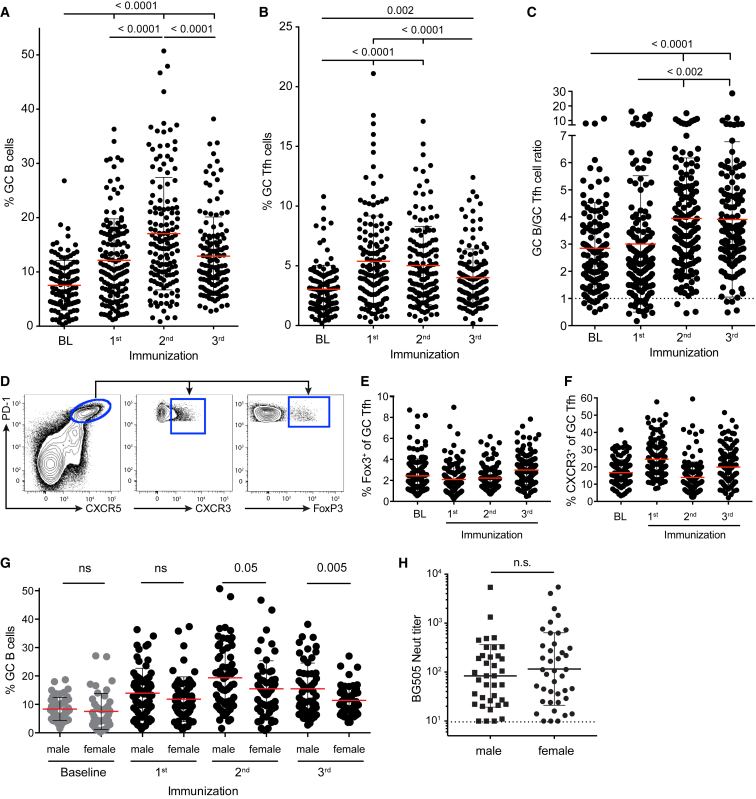
GC Dynamics across All Immunized Animals(A–C) GC B cell frequency (A), GC Tfh cell frequency (B), and ratio of GC B cells to GC Tfh cells (C) for all study animals at baseline (BL) and after the first, second, and third immunizations. Points represent individual LNs (n = 144; 72 animals × 2 LNs).(D–F) Subpopulations of GC Tfh cells. (D) Flow cytometry of GC Tfh cell sub-populations. Gates were set on the basis of total CD4+ T cells (Figure S6B). (E) Frequency of FoxP3+ GC Tfr cells. (F) Frequency of CXCR3+ GC Tfh cells.(G) GC B cell frequencies separated by gender.(H) BG505 nAb titers separated by gender.All nAb titer data represent geometric mean titers with geometric SD. All cell-frequency data represent the mean and SD. See also Figure S6.